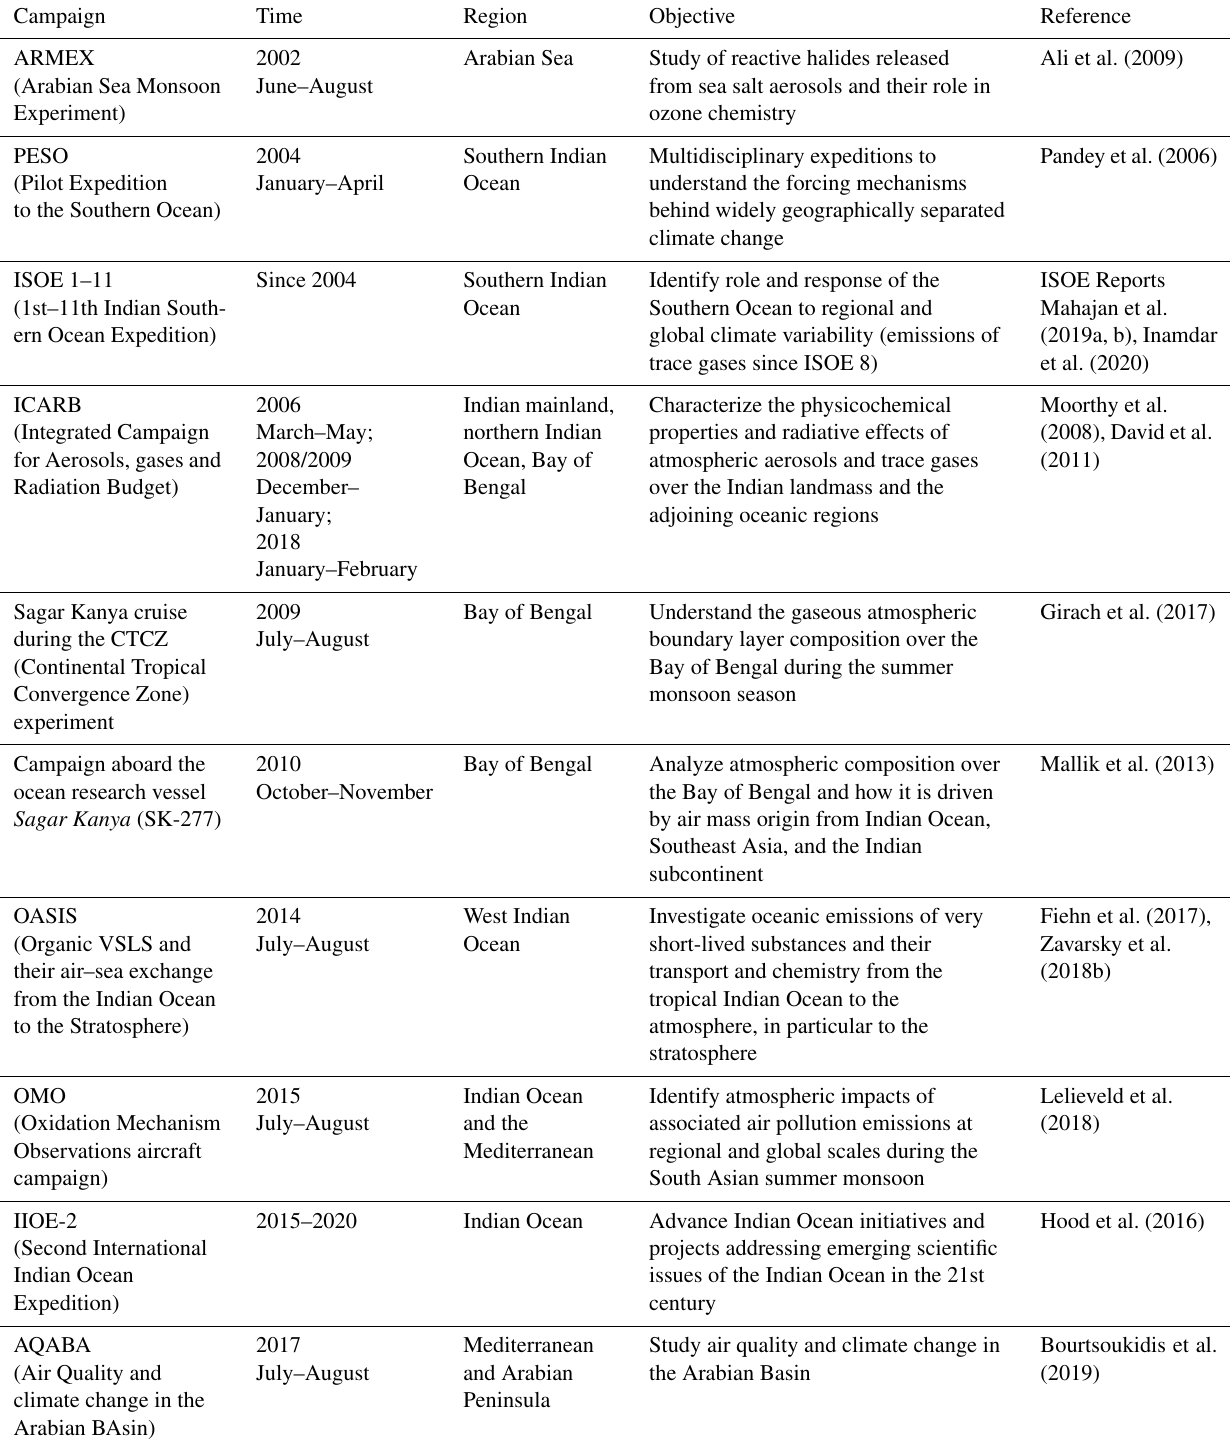
Table 1. Summary of campaigns in the Indian Ocean for the 21st